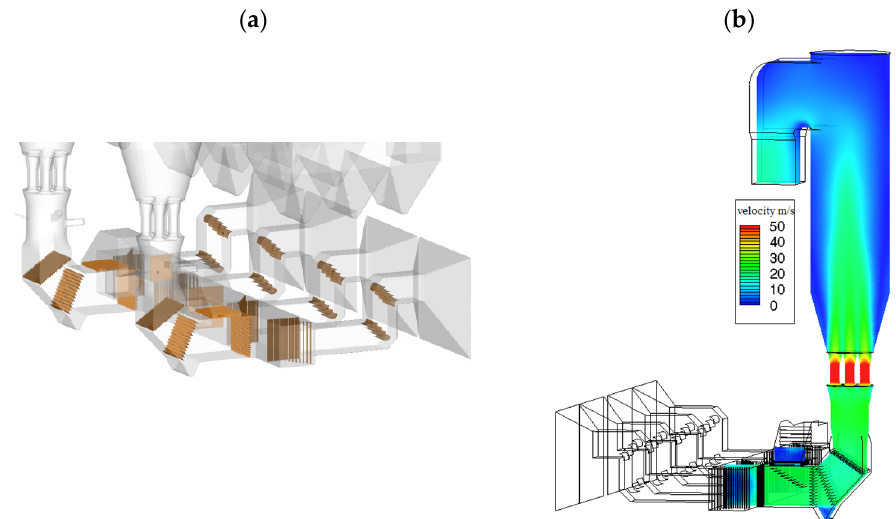
Figure 3. Layout of baffle plates and flow field distribution in desulfurization tower. ( a ) Baffle plates layout at flue; ( b ) flow field distribution at xz cross section.